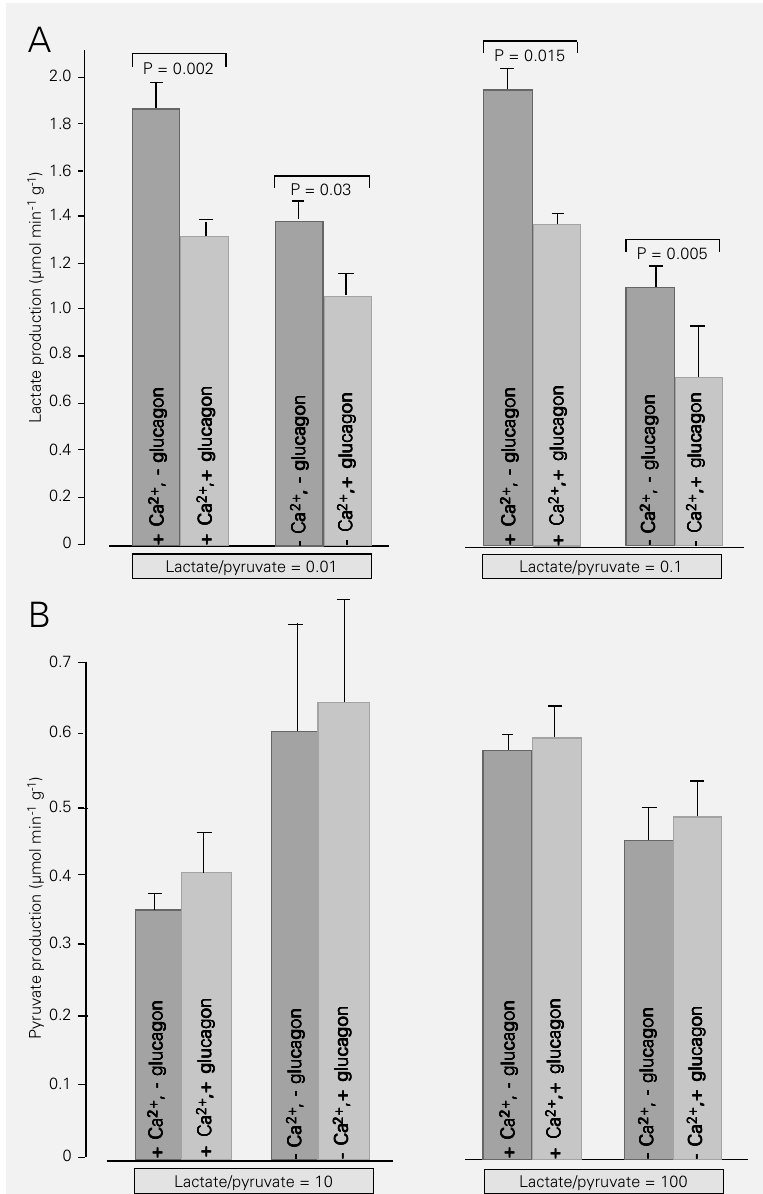
Figure 6 - Influence of glucagon and Ca 2+ on lactate (A) and pyruvate (B) production. The data were obtained from experiments performed according to the protocol illustrated in Figure 1. Steady-state rates of lactate or pyruvate production in the presence of substrates alone or substrates plus glucagon, corrected for the small basal rates (before substrate infusion), are represented in addition to the corresponding mean standard errors (N = 3 to 5). The substrate concentrations were the following: lactate/pyruvate ratio = 0.01, 0.037 mM lactate and 3.71 mM pyruvate; lactate/pyruvate ratio = 0.1, 0.35 mM lactate and 3.4 mM pyruvate; lactate/pyruvate ratio = 10, 3.5 mM lactate and 0.35 mM pyruvate; lactate/ pyruvate ratio = 100, 3.71 mM lactate and 0.037 mM pyruvate. The P values refer to the paired Student t -test, which was applied to test the significance of the changes produced by glucagon. Lactate production in Ca 2+ -free perfusion (A) differed from the corresponding controls: P = 0.035 for lactate/pyruvate equal to 0.01 and P = 0.015 for lactate/pyruvate equal to 0.1 (Student t -test). No statistically significant differences were observed in the case of pyruvate production (B) (i.e., P>0.05 in all